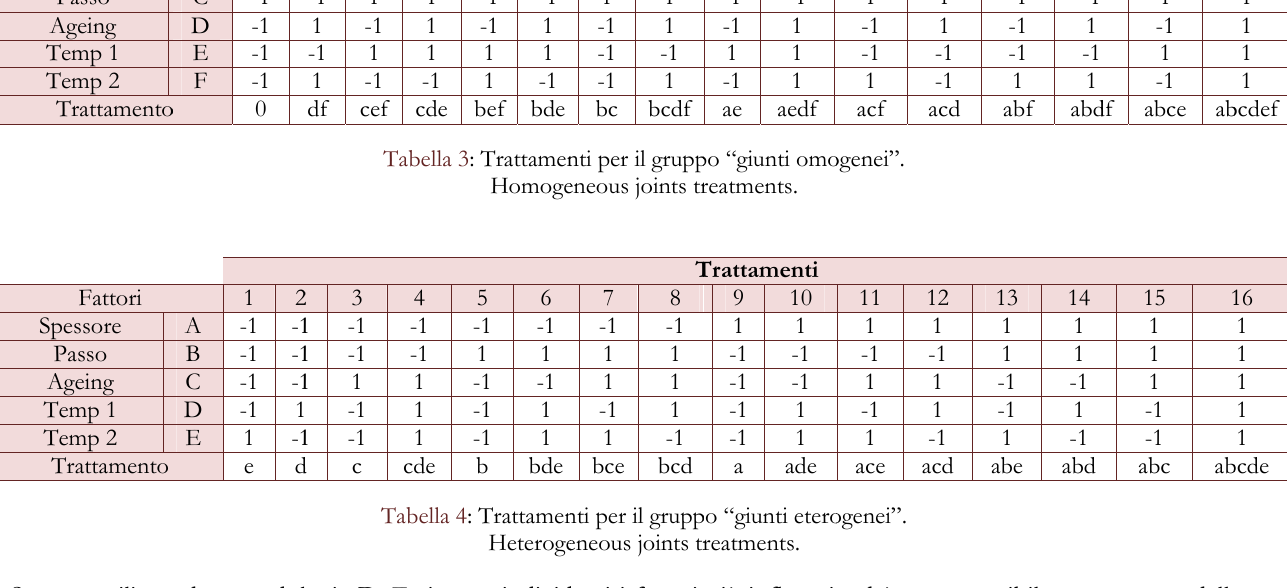
Spessore Passo Ageing Trattamento